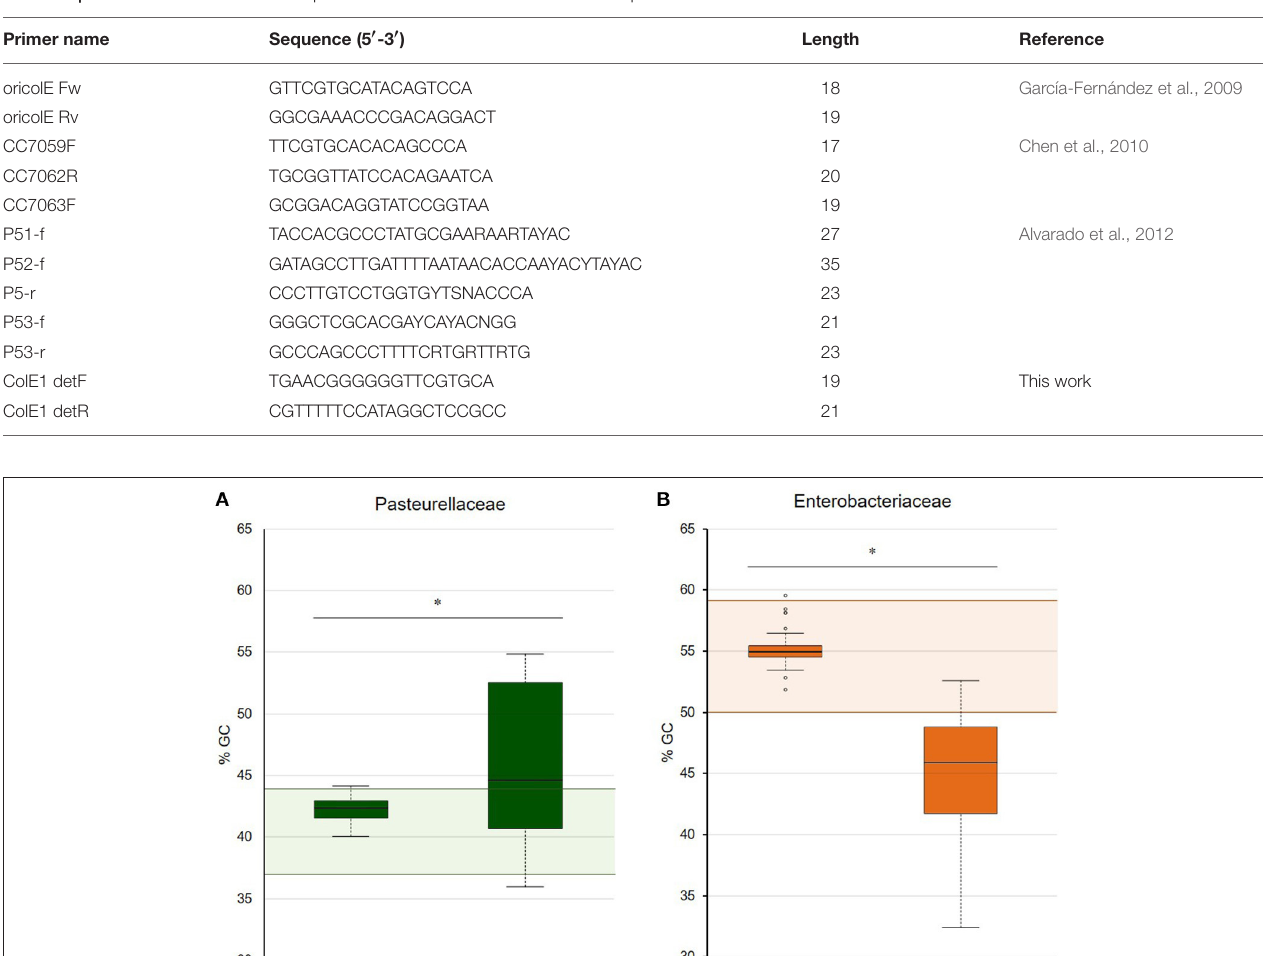
TABLE 2 | Primers used to detect ColE1 plasmids in Enterobacteriaceae isolates in previous studies.